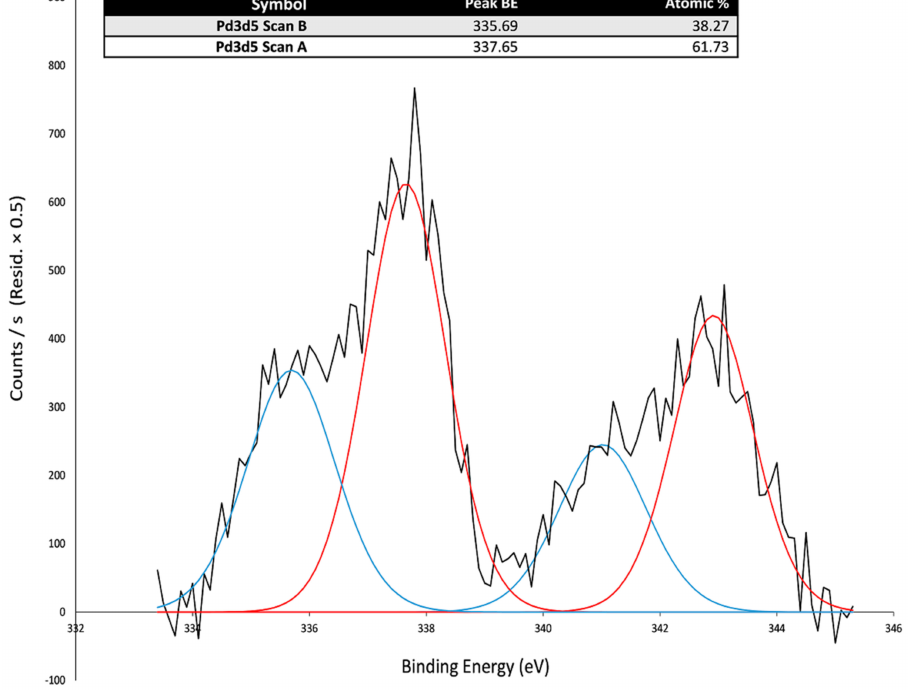
Figure 6. XPS spectra of i -PdCl 2 (TPPTS) 2 in the Pd3d